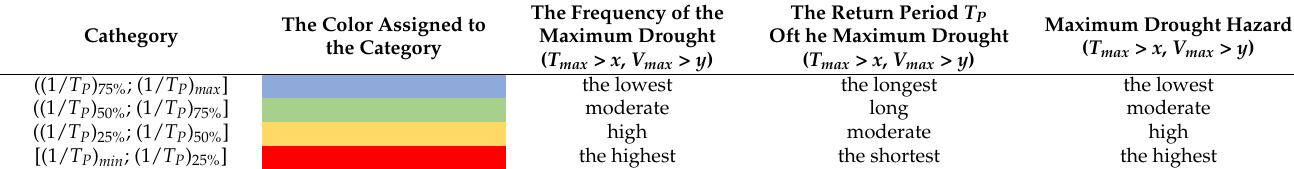
Table 4. Color and linguistic coding in the adopted T P quartile classification of the frequency of occurrence of the maximum annual droughts ( T max > x , V max > y ), ( x , y ) = ( T max ,10 , V max ,10 ) i ( T max , V max )